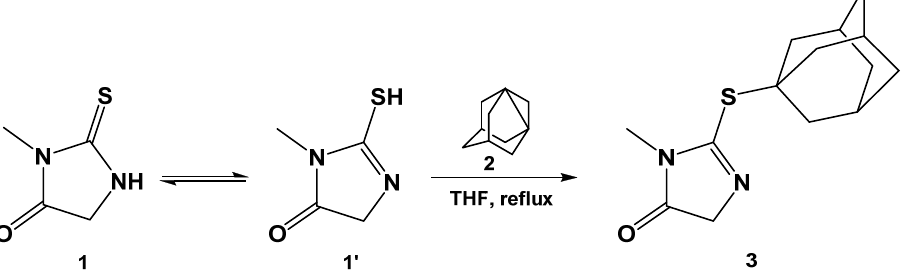
Scheme 1. Main route of the reaction of 1,3-dehydroadamantane ( 2 ) with 3-methyl-2-thioxoimidaz-